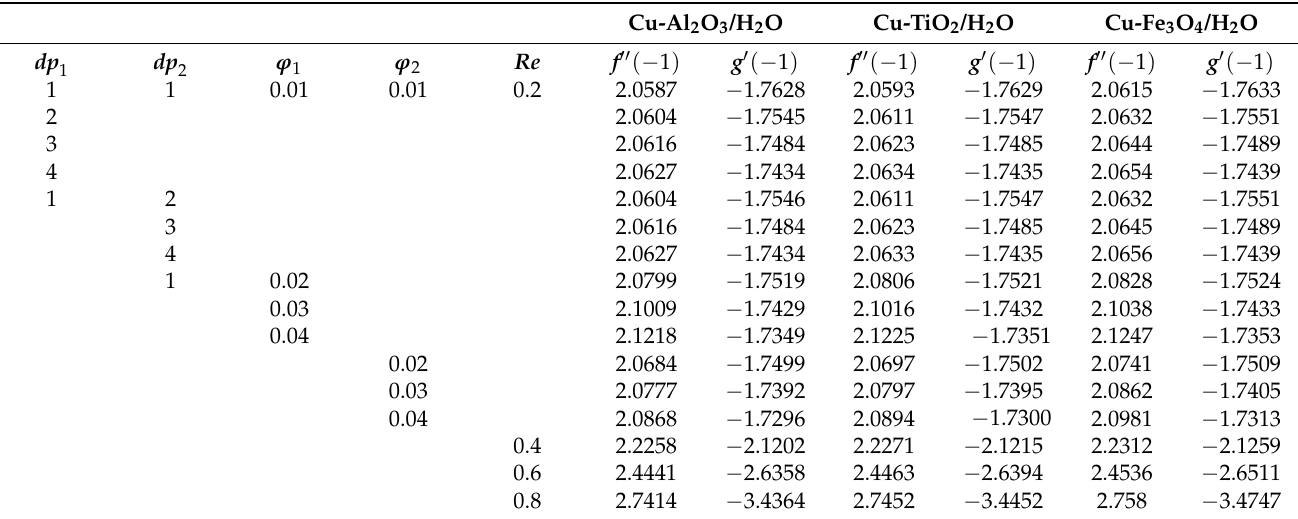
Table 3. Different parameters of the effect in shear stress and tensional